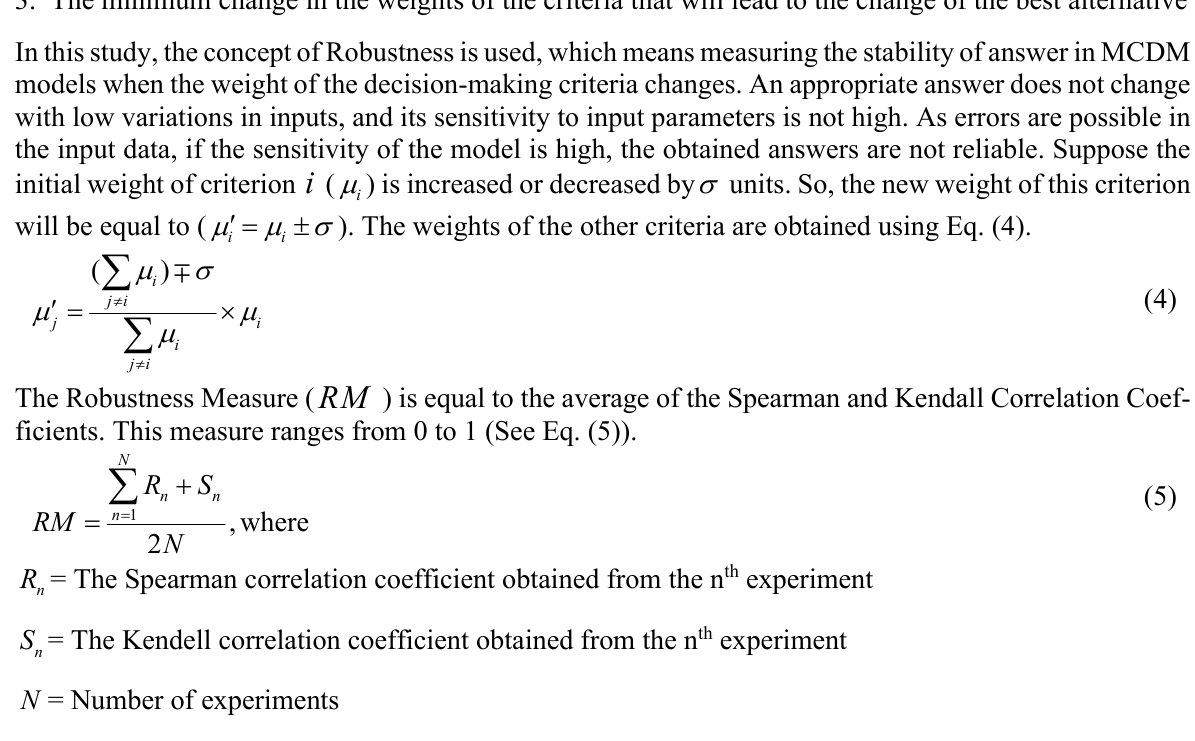
S = The Kendell correlation coefficient obtained from the n th experiment n N = Number of